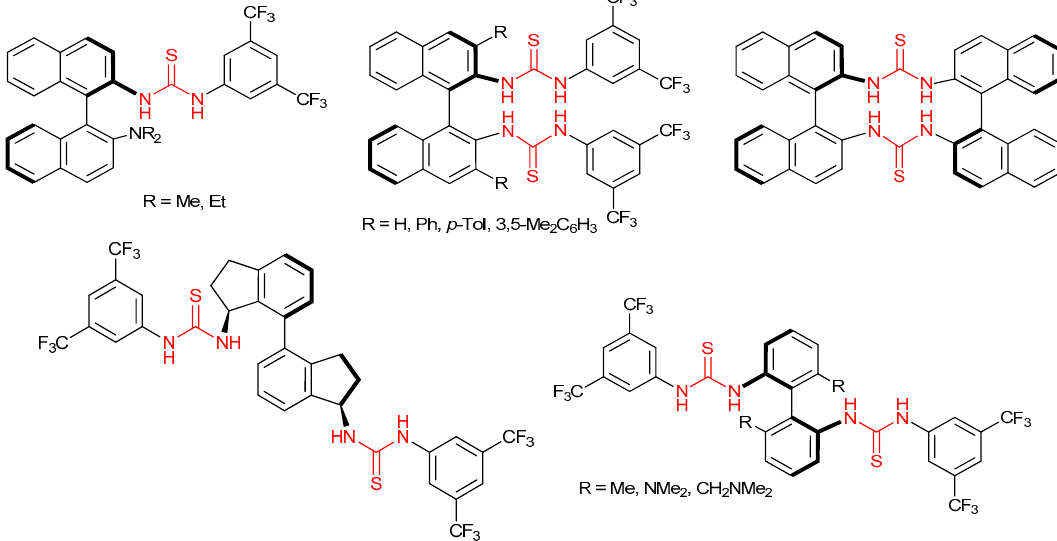
Figure 26. Examples of thioureas and bis-thioureas with axial chirality [28,29,323–328].